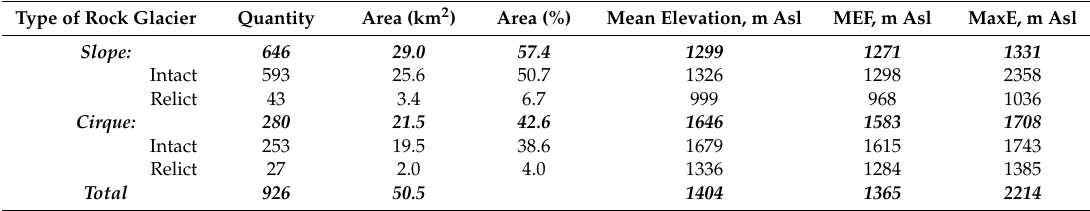
Table 4. Statistics of Rock Glaciers of the Momsky Range.